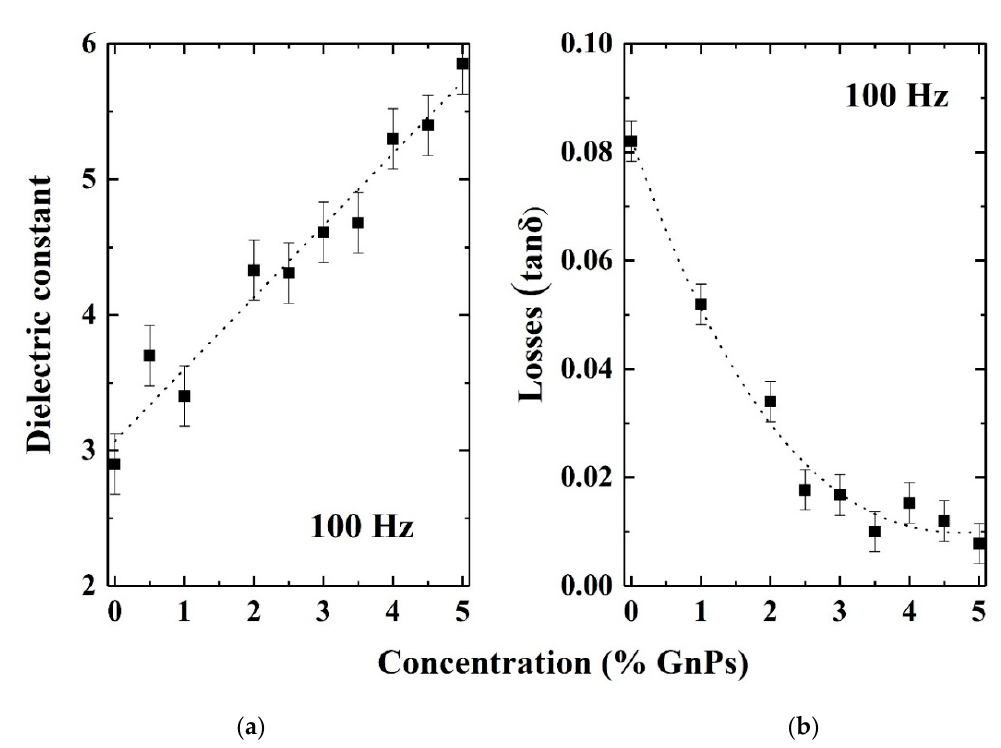
Figure 8. ( a ) Dielectric constant and ( b ) Loss (delta) versus concentration of graphene (% GnPs wt.).